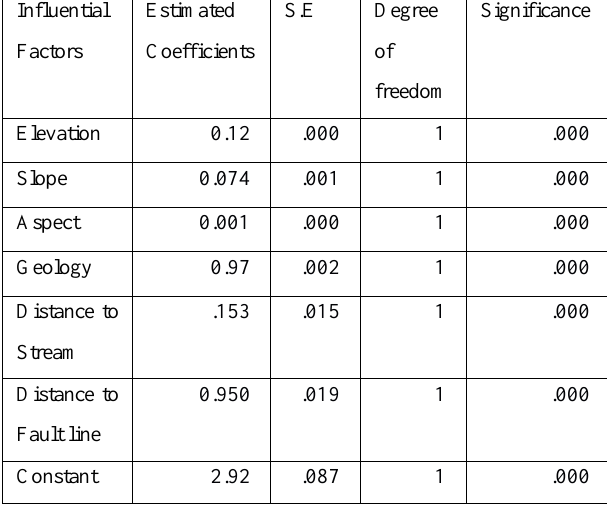
Table 1: Estimated Coefficients from the logistic regression